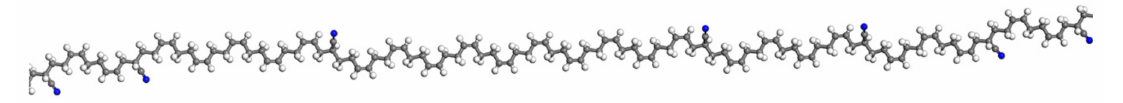
Figure 1. The repeating units of butadiene ( a ) and acrylonitrile ( b ).